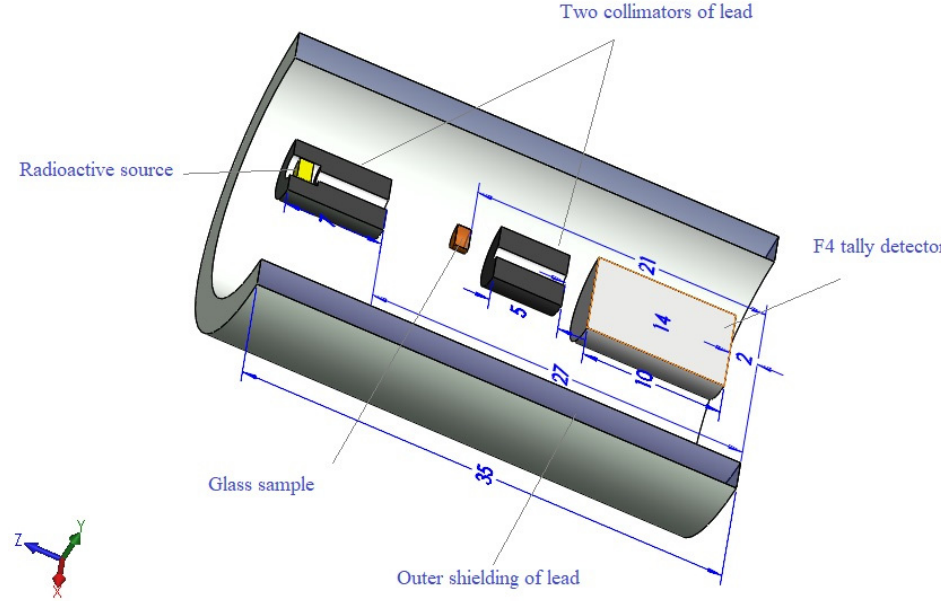
Figure 1. The created geometry describes the Monte Carlo simulation input file.